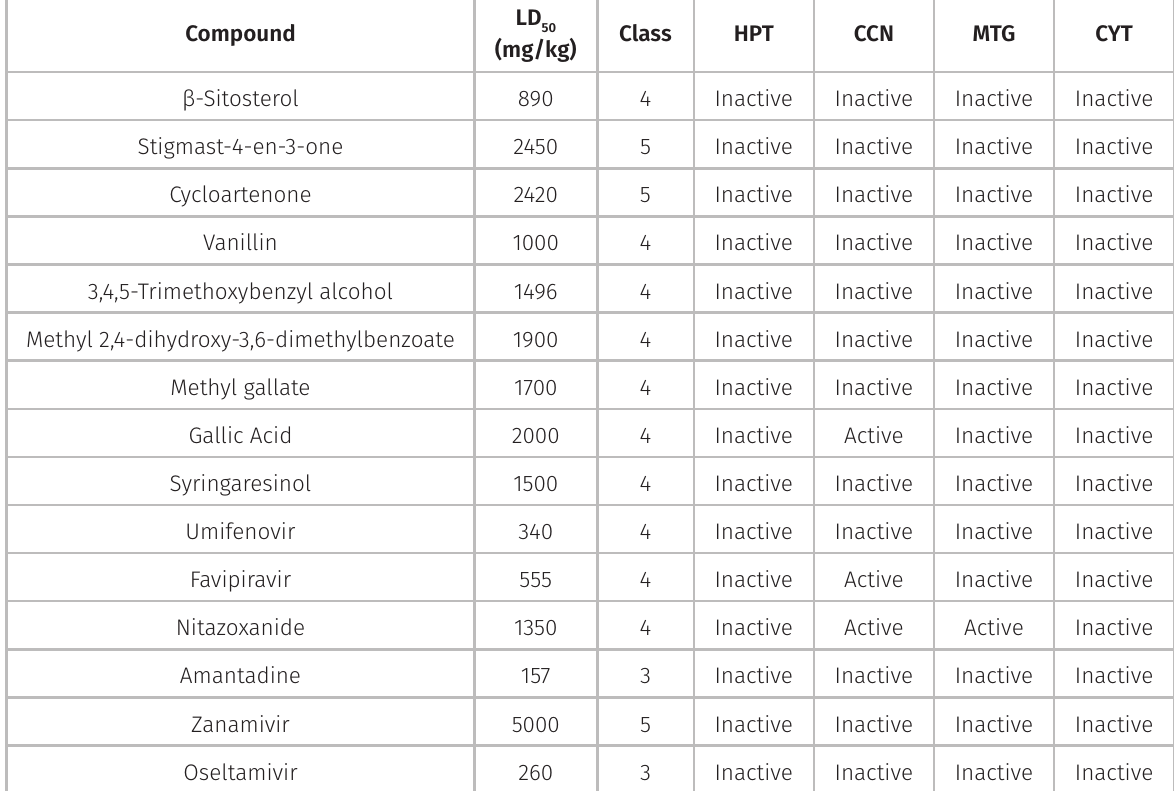
Table IV. In silico toxicity studies of S. brasiliensis phytocompounds and positive controls. LD Hepatotoxicity; CCN: Carcinogenicity; MTG: Mutagenicity; CYT: